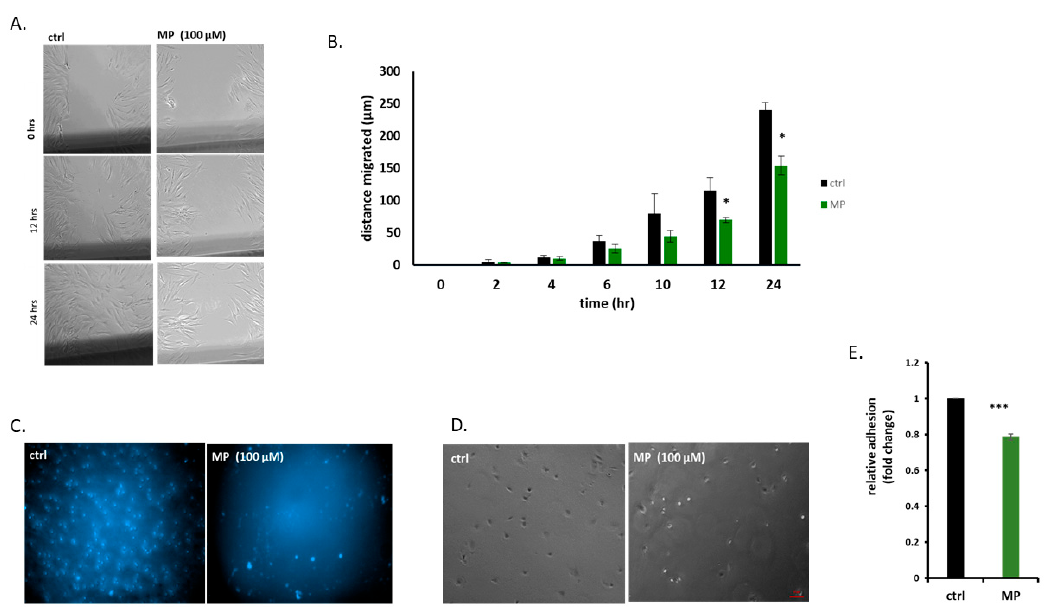
Figure 5. MP inhibits VSMC migration, invasion, and adhesion. ( A ) Cells were treated with MP (100 µ M) and cell migration was assessed by scratch assay. Images were taken at the indicated time points (Scale bar, 50 µ m). ( B ) Values are represented as mean ± SEM of distance migrated ( n = 3 replicates) (* p < 0.05). ( C ) Cells were treated with MP (100 µ M). Cell invasion was evaluated using invasion assay. Representative photomicrographs showing the e ff ect of MP on invading cells. ( D ) Cells were treated with MP (100 µ M) and allowed to adhere for 1 hr. Representative photomicrographs of the e ff ect of MP on VSMC adhesion. Scale bar, 50 µ m. ( E ) Values are represented as mean ± SEM of relative fold inhibition of vehicle-treated cells (* p < 0.05). One-way ANOVA was performed for all panels.